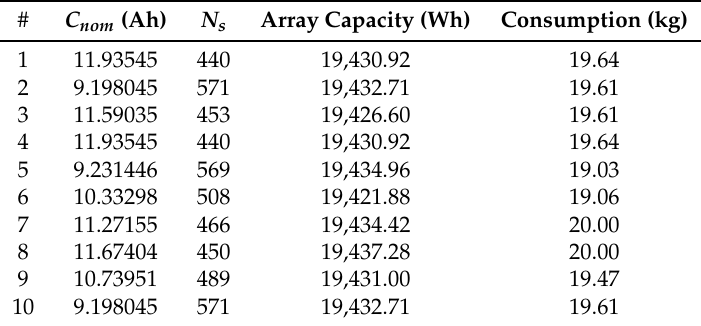
Table 4. Fuel consumption of HE – RCV .